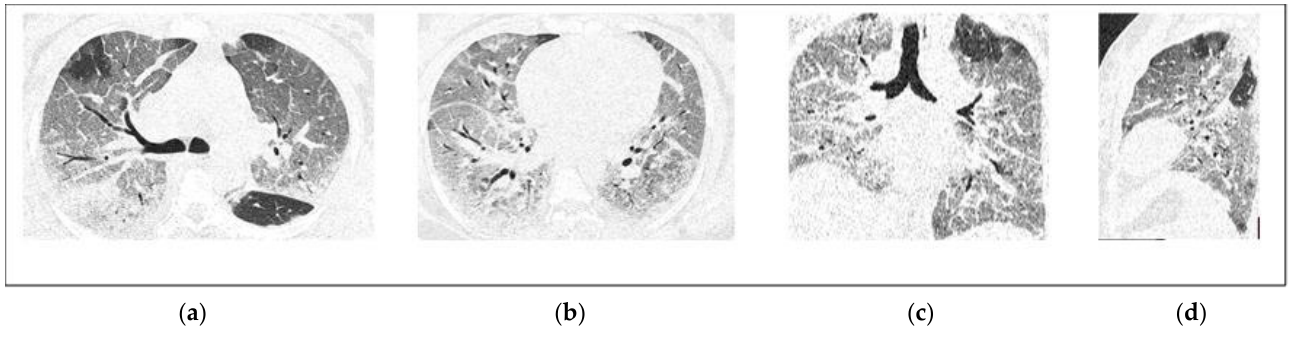
Figure 3. Non-contrast chest CT axial ( a , b ), coronal ( c ), and sagittal ( d ) reconstructed images for a 52-year-old female with severe COVID-19 infection. CT images show large patchy ground-glass opacities and a predominant crazy paving pattern in multiple lung segments in both lobes. The TSS is 18. Table 2. Characteristics of HRCT chest, main patterns, and features in patients with COVID-19 infection, and differences between survivor and non-survivor groups.